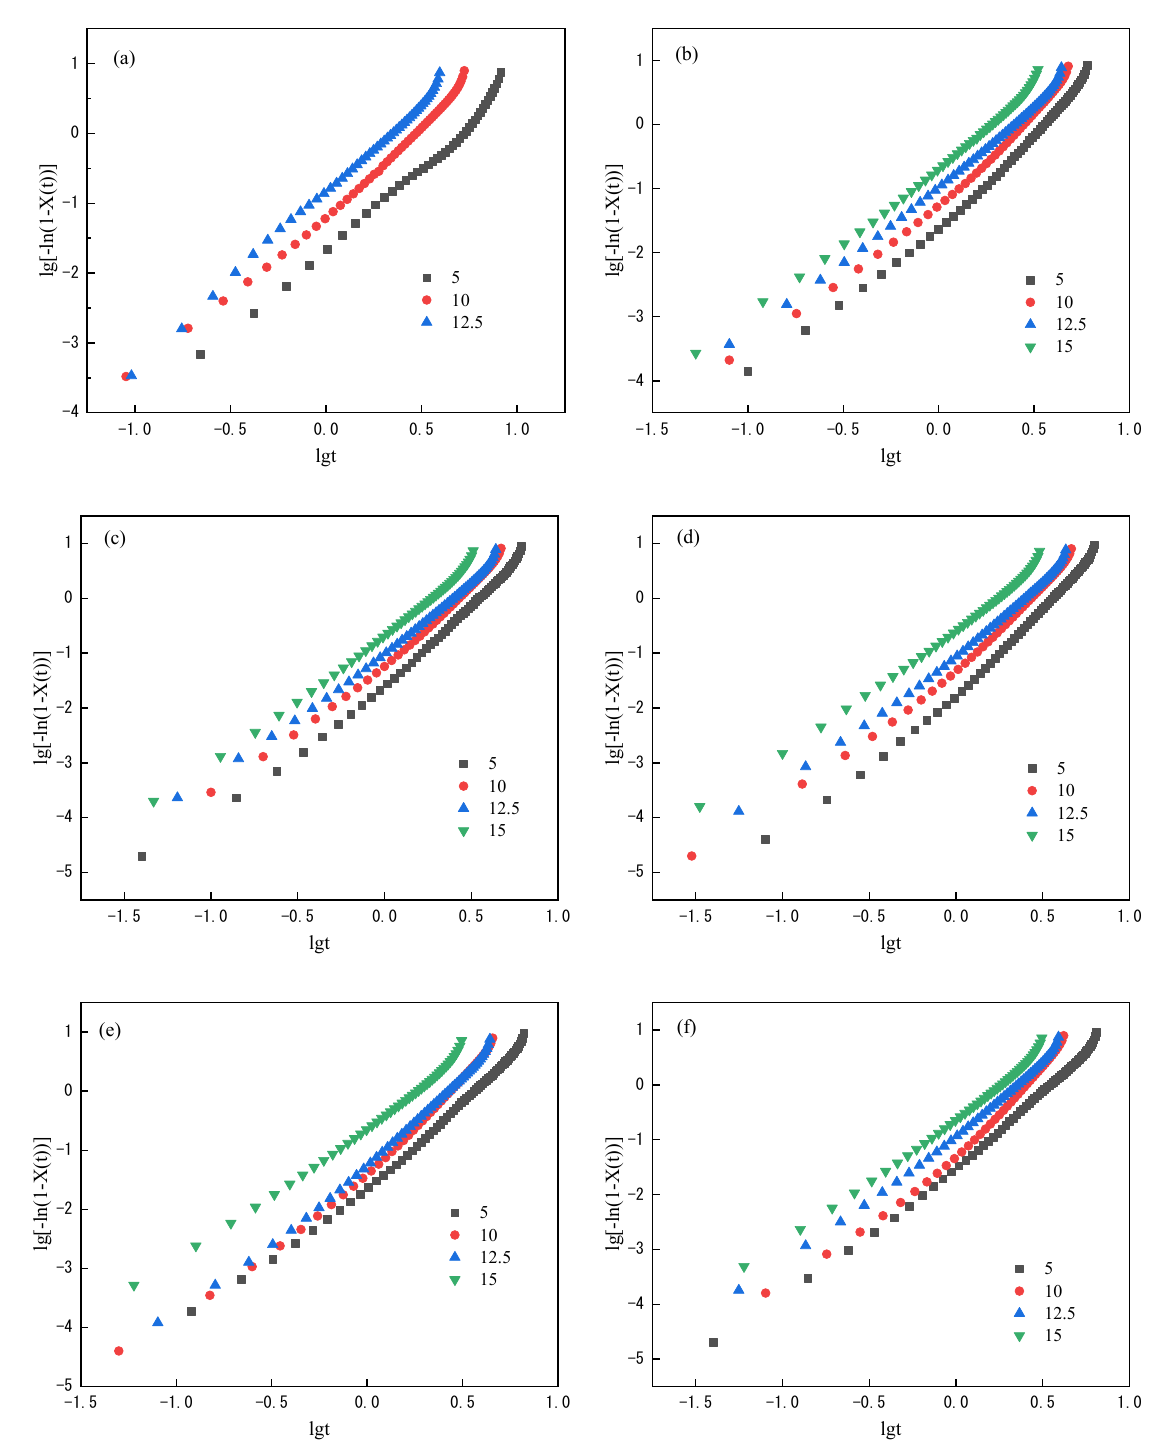
Figure 5. Relationship between lg[ − ln(1 − X ( t ))] and lg t at different crystallization cooling rates. ( a ) PET; ( b ) PSLDH 0.01 wt%; ( c ) PSLDH 0.03 wt%; ( d ) PSLDH 0.05 wt%; ( e ) PSLDH 0.07 wt%; ( f ) PSLDH 0.1 wt%.